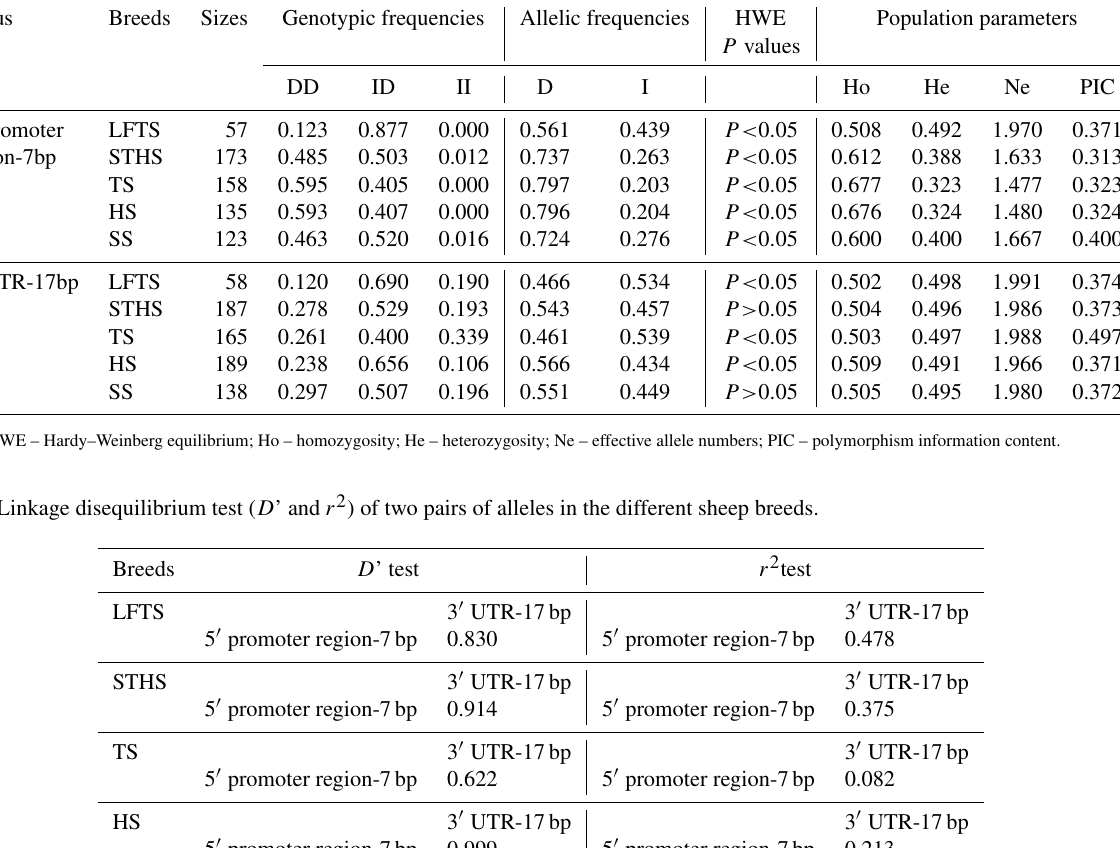
TS 3 (cid:48) UTR-17bp